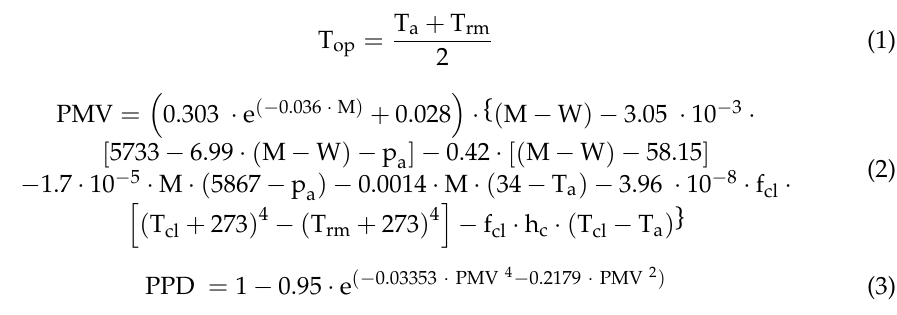
7 of 23 Figure 4. Subjective measuring tool. Table 2. Summary of patients’ ability to answer the questions . Gender